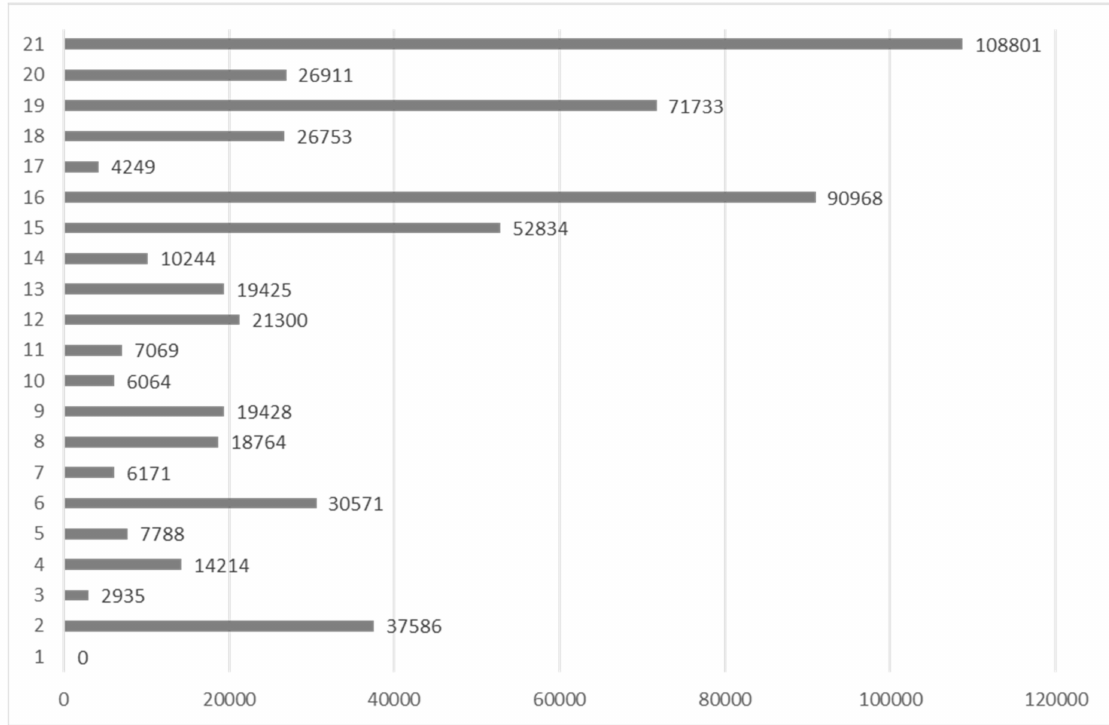
Figure 4. Total savings per city—gas distribution costs